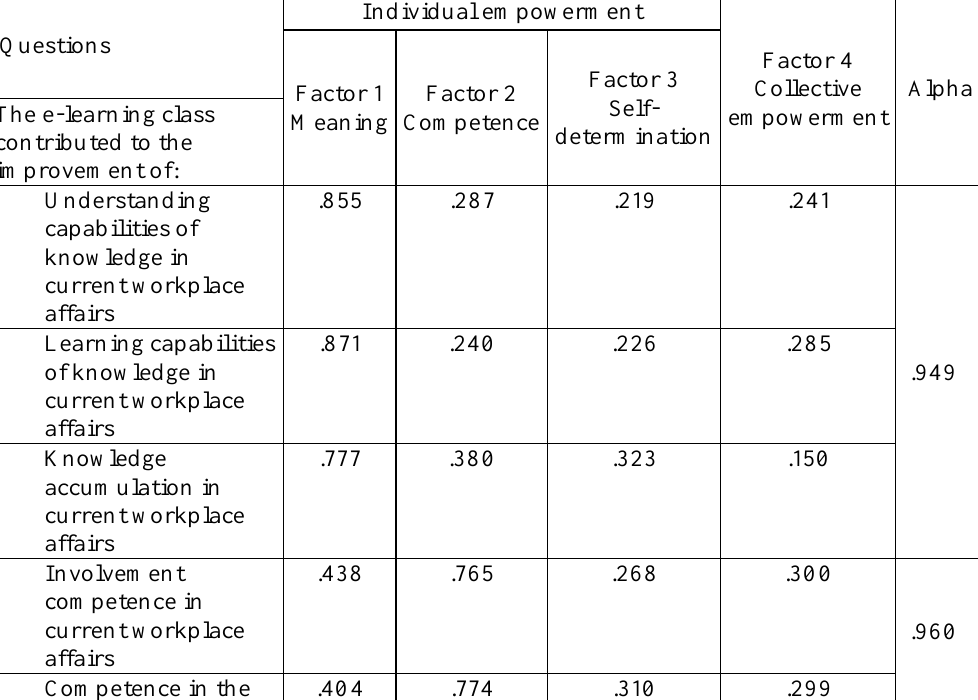
Rotated Component Matrix: Individual Empowerment and Collective Empowerment